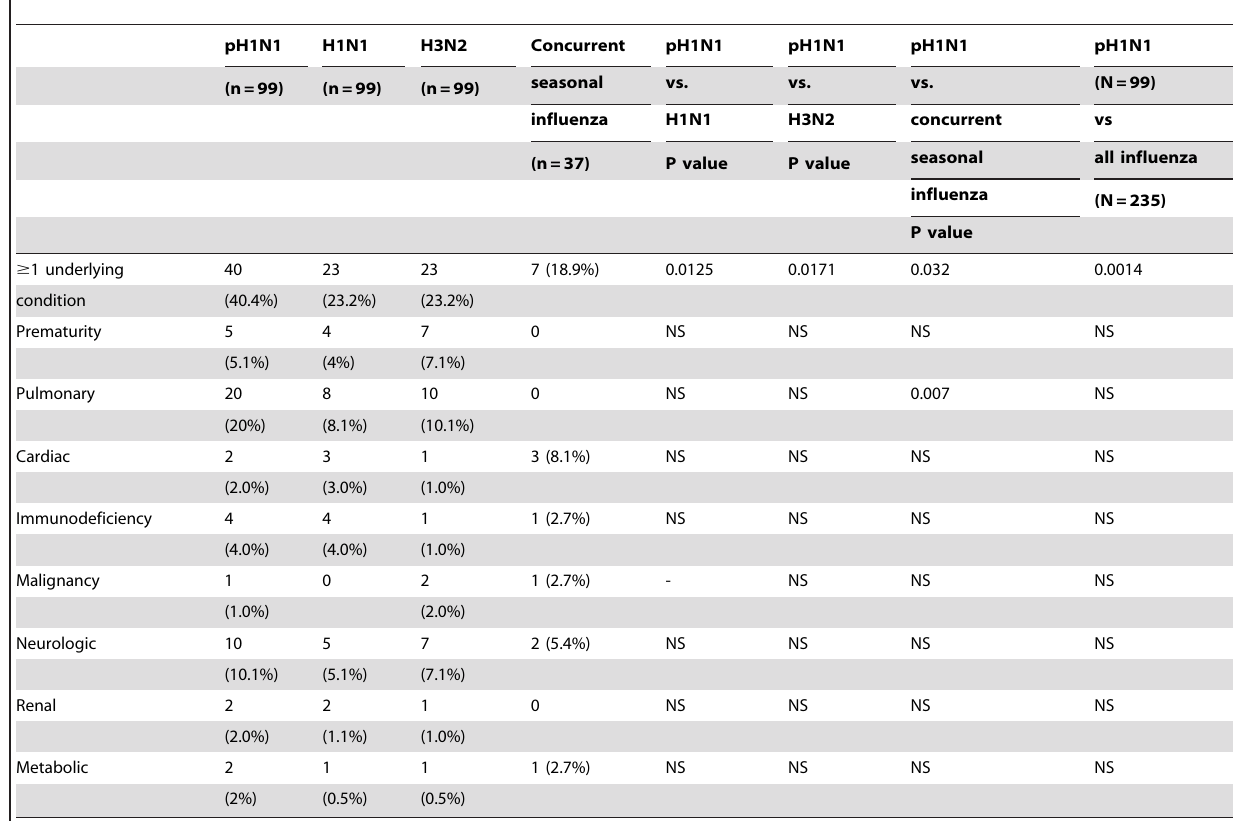
Table 1. Comparisons of pre-existing high risk conditions of children hospitalized for influenza A pH1N1 with age- matched controls hospitalized for seasonal H1N1 and H3N2, and with children hospitalized for seasonal influenza concurrently during the study period,